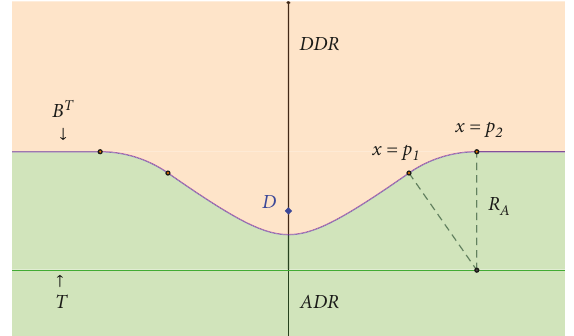
Figure 2: The barrier of the reach-avoid game with a time limit of A